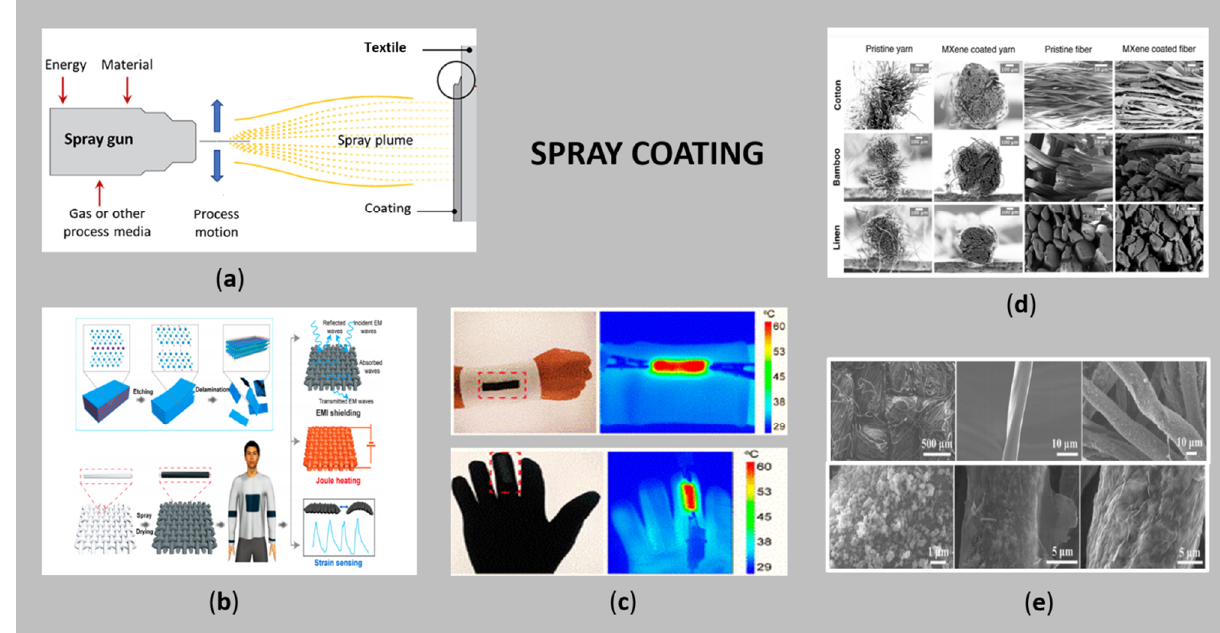
Figure 7. ( a ) Schematic of the thermal spraying (adapted from Ref. [122]); ( b ) scheme of the spray coating process of